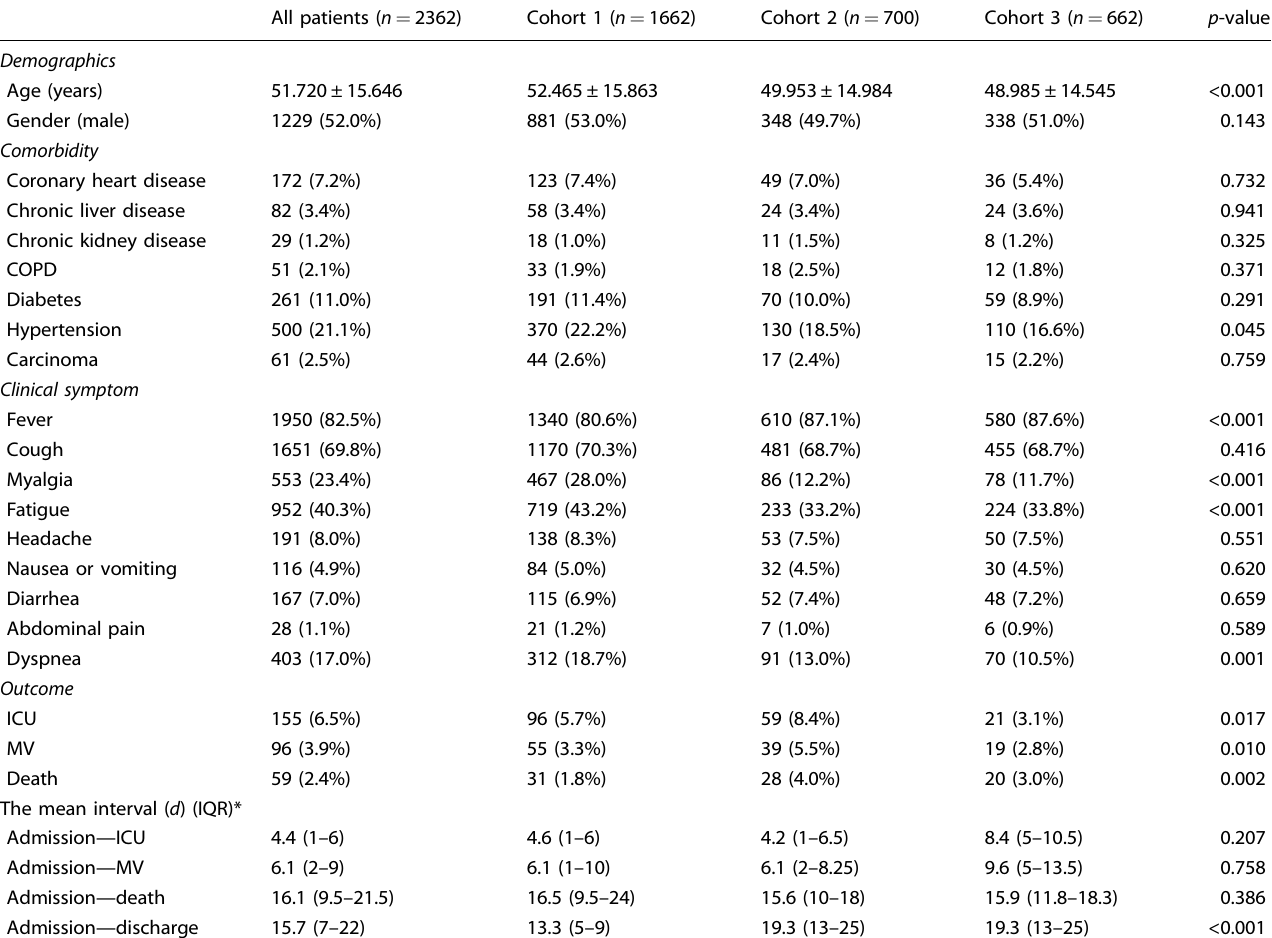
Table 1. Clinical characteristics of COVID-19 patients in Cohort 1, Cohort 2, Cohort 3, and the whole cohort. All patients ( n = 2362)